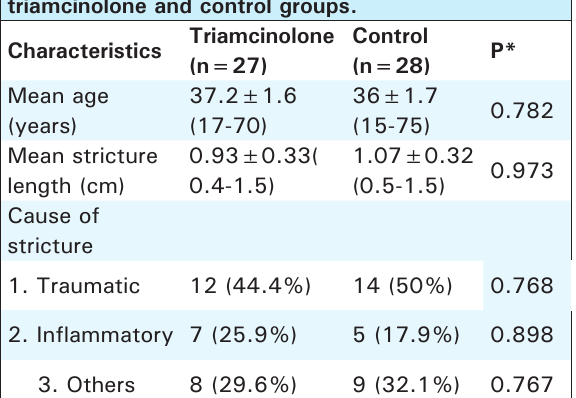
Table 2. Baseline characteristics of patients in triamcinolone and control